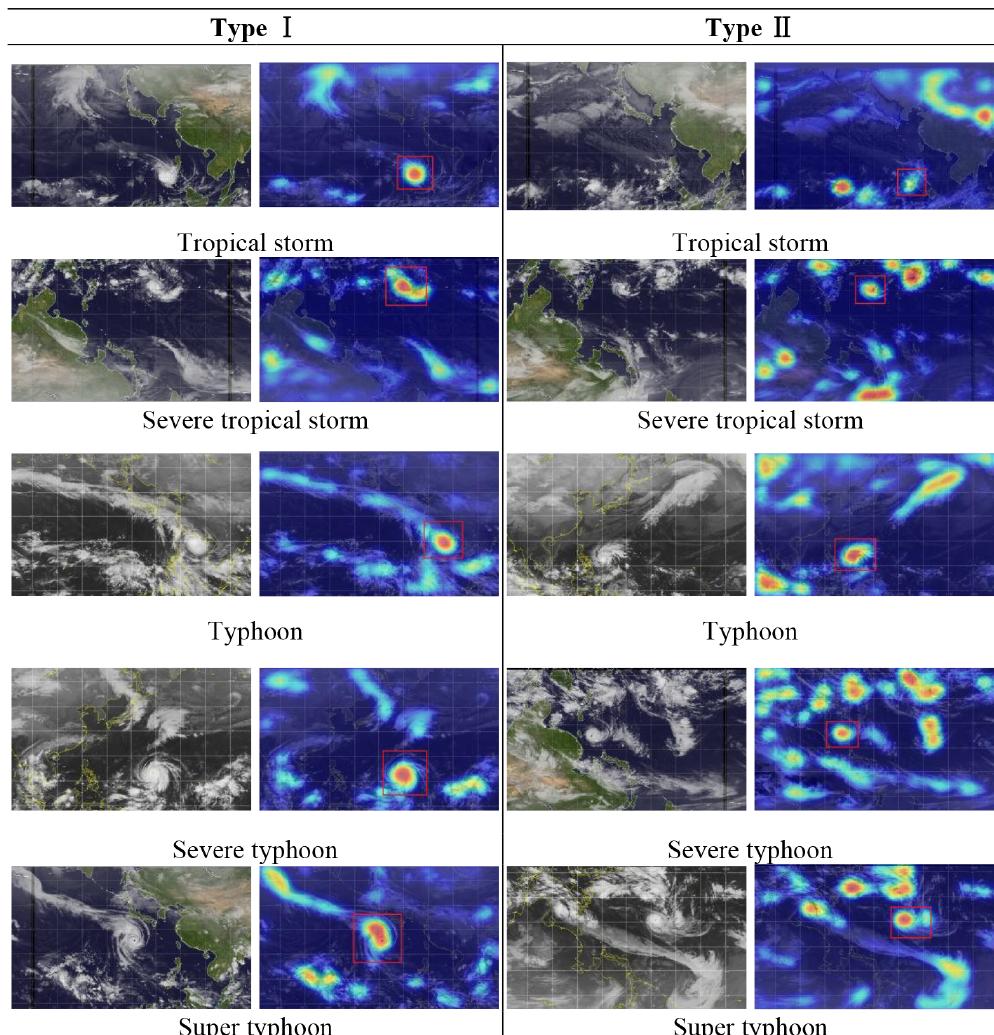
Figure 18. Heat maps of some successfully identified TC images compared with associated NWPO images that contain a single TC.